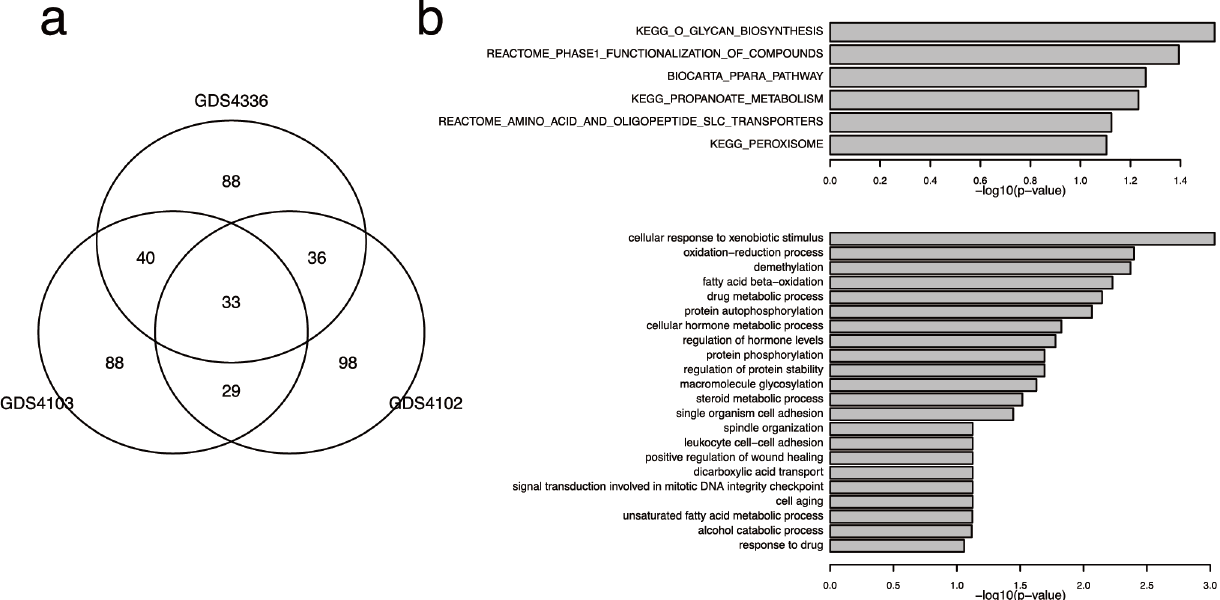
Fig 2. Summary of the predicted key pancreatic cancer (KPC) enzymes. A. Venn diagram for the predicted key enzyme-coding genes for each of the three pancreatic cancer datasets. B. The enriched pathways and biological processes for the KPC enzymes predicted in all three cancer datasets.